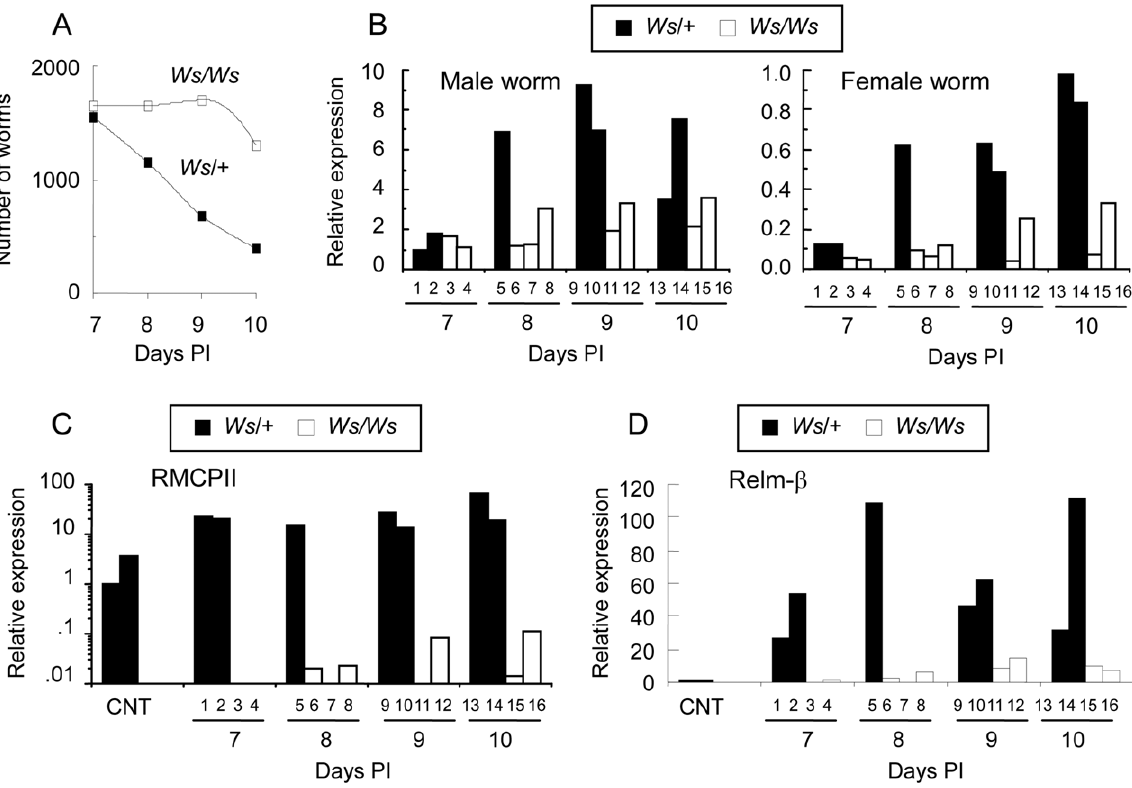
Figure 5. Hsp gene expression in adult worms in mast cell-deficient rats. A . Mean worm burdens in the small intestine of mast cell-deficient Ws/Ws and the control Ws / + rats after infection with 2,000 infective-L3 larvae. B . Nb -Hsp12.6 gene expression levels in male and female worms recovered from Ws/Ws and Ws / + rats. Individual data are shown with rat ID numbers (1–16) beneath the columns. The expression level in the male worms from rat No. 1 is shown as 1.0. C . Gene expression levels of RMCP II in the intestinal mucosa of Ws/Ws and Ws / + rats. The expression level in one of the uninfected Ws / + rats (CNT) is shown as 1.0. D . Gene expression levels of Relm- b in the intestinal mucosa of Ws/Ws and Ws / + rats. The level in one of the uninfected Ws / + rats (CNT) is shown as